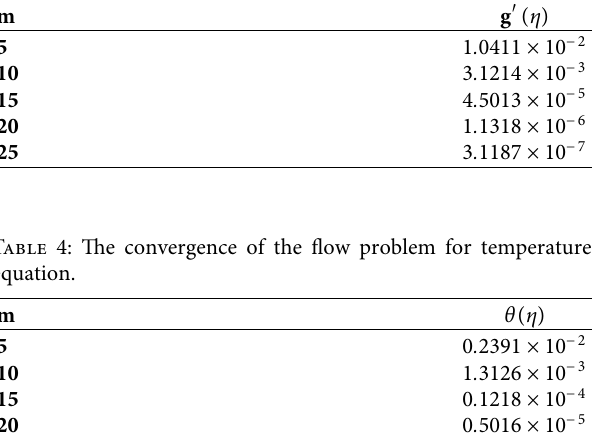
, n (magnetic field parameter, e